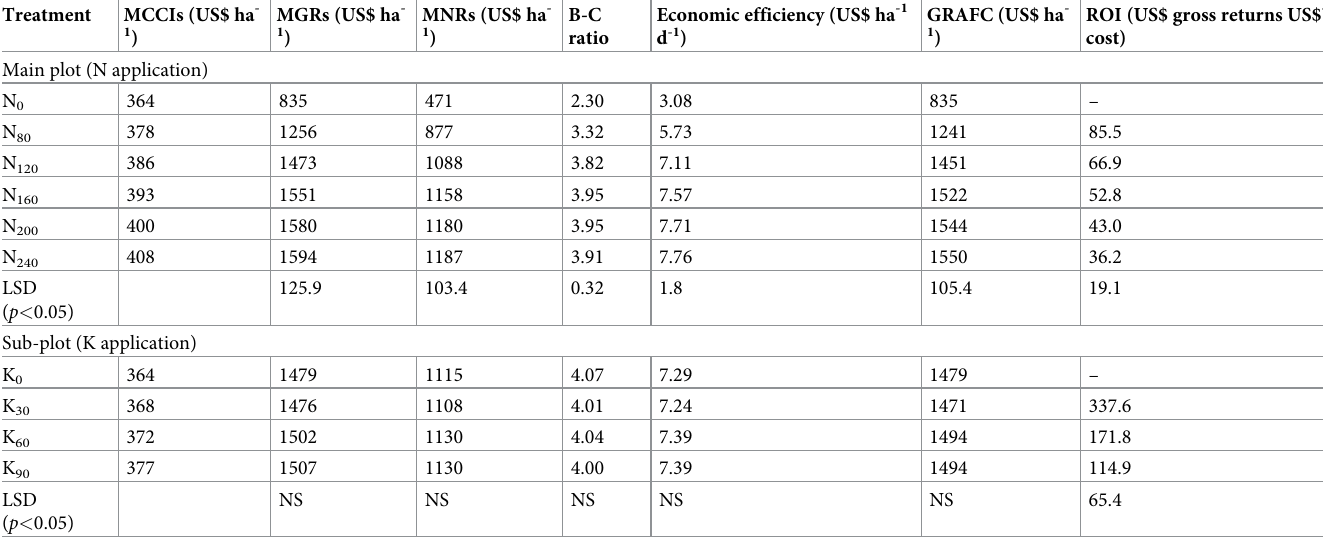
Table 7. Effect of nitrogen (N) and potassium (K) application on economic indices viz. mean cost of cash inputs (MCCIs), mean gross returns (MGRs), mean net returns (MNRs), benefit-cost (B-C) ratio, economic efficiency, gross returns above the fertilizer cost (GRAFC) and returns on investment on fertilizer application (ROI) for wheat ( Triticum aestivum L.) cultivation in a sandy loam soil in sub-tropical India. ( Data pooled for two study years ). Treatment MCCIs (US$ ha - 1